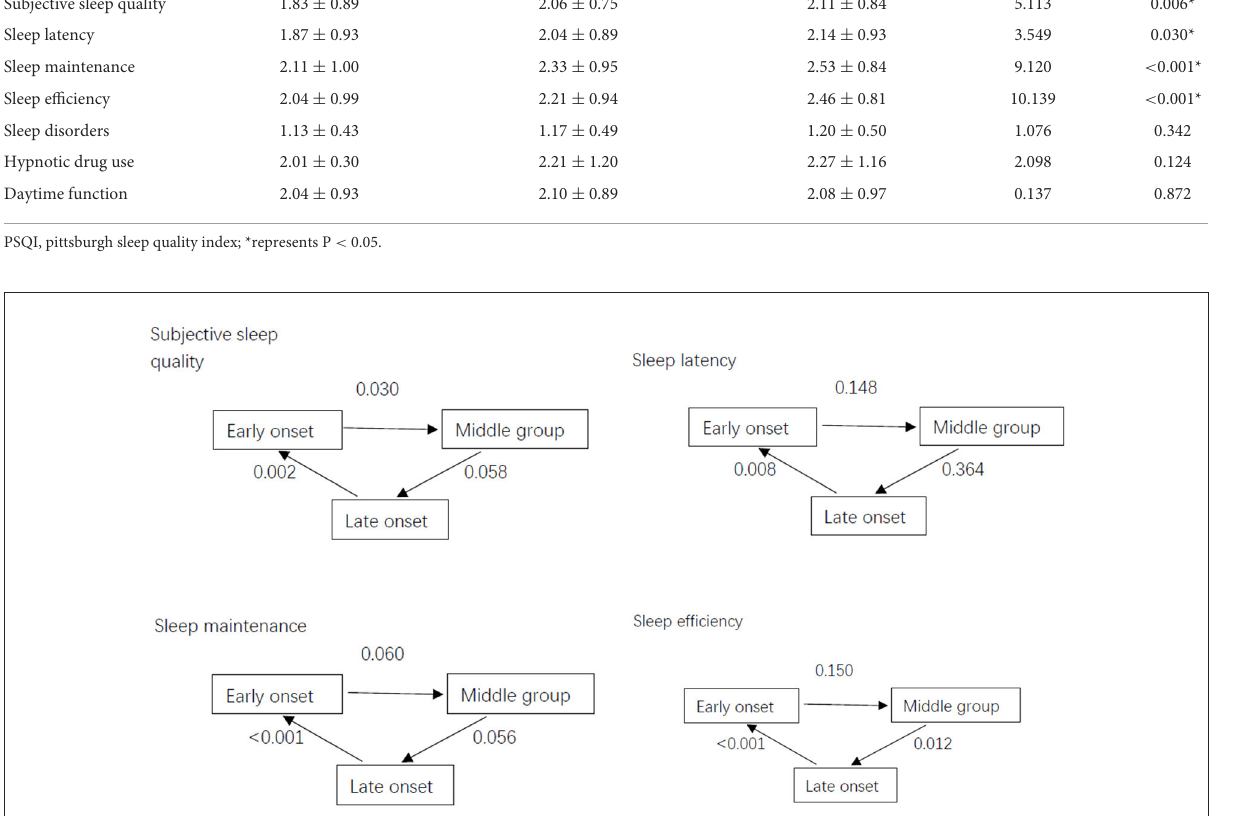
FIGURE1 Differences in PSQI factor scores of insomnia patients among the three